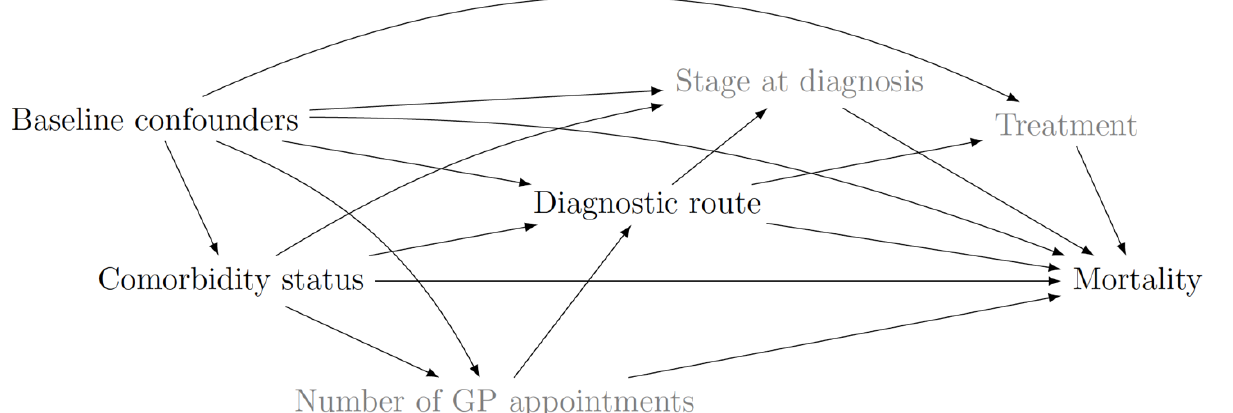
Figure 1. For patients diagnosed with DLBCL or FL in England between 2005 and 2013, this causal diagram represents the total effect of comorbidity on death mediated by diagnostic route, adjusted for baseline confounders (i.e., age at diagnosis, sex, deprivation, and ethnicity). Unmeasured confounders are stage at diagnosis, treatment, and number of general practitioner appointments.